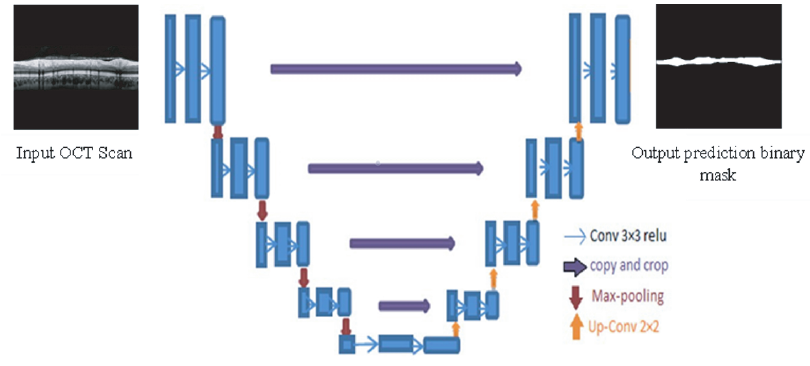
Figure 2. Summary of the U-net architecture. The network receives input X and generates a prediction mask.